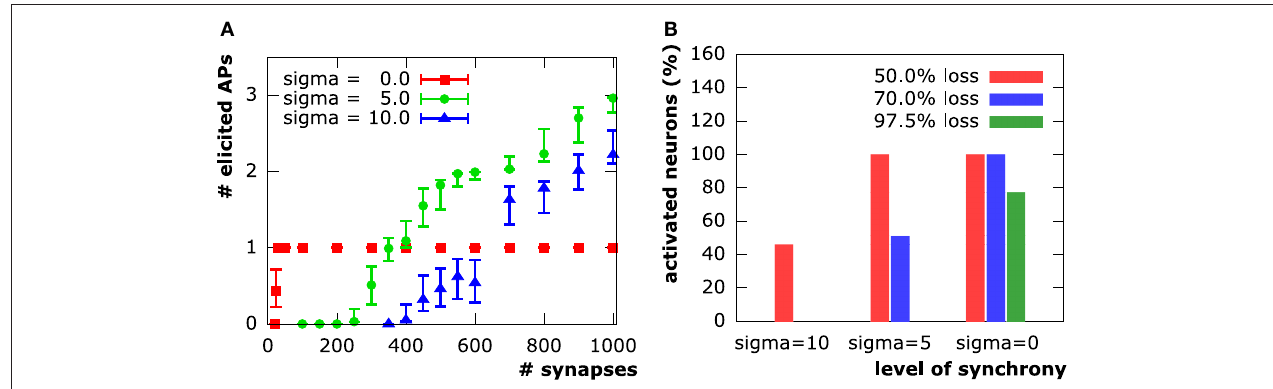
FIGURE 7 | (A) Number of evoked action potentials in simulations of a layer 3 pyramidal neuron upon synaptic activation at varying levels of synapse loss. Experiments on N 100 sample distributions of synapses with initiation of synaptic activity drawn from a normal distribution N = Square, circle and triangle symbols represent mean values, vertical bars show standard deviations. (B) Synapse input synchrony counteracts synapse loss. The y-axis indicates the percentage of simulated cells that evoked at least one action potential upon synaptic activity in the three examined levels of synchrony ( σ onset ) at three different levels of synapse 45ms , 15ms , 0ms ∈ { }